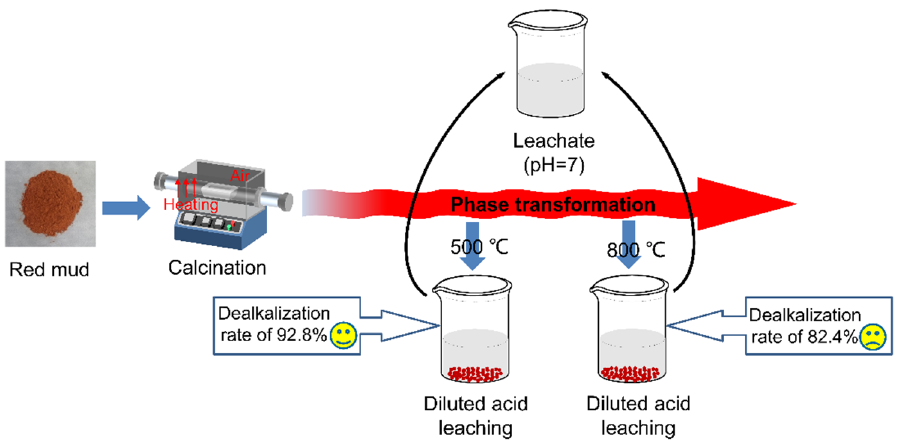
Figure 10. Schematic diagram of the diluted acid leaching strategy. Table 4. Comparison of the dealkalization rate and leaching condition between diluted acid leach- ing and traditional acid or water leaching.